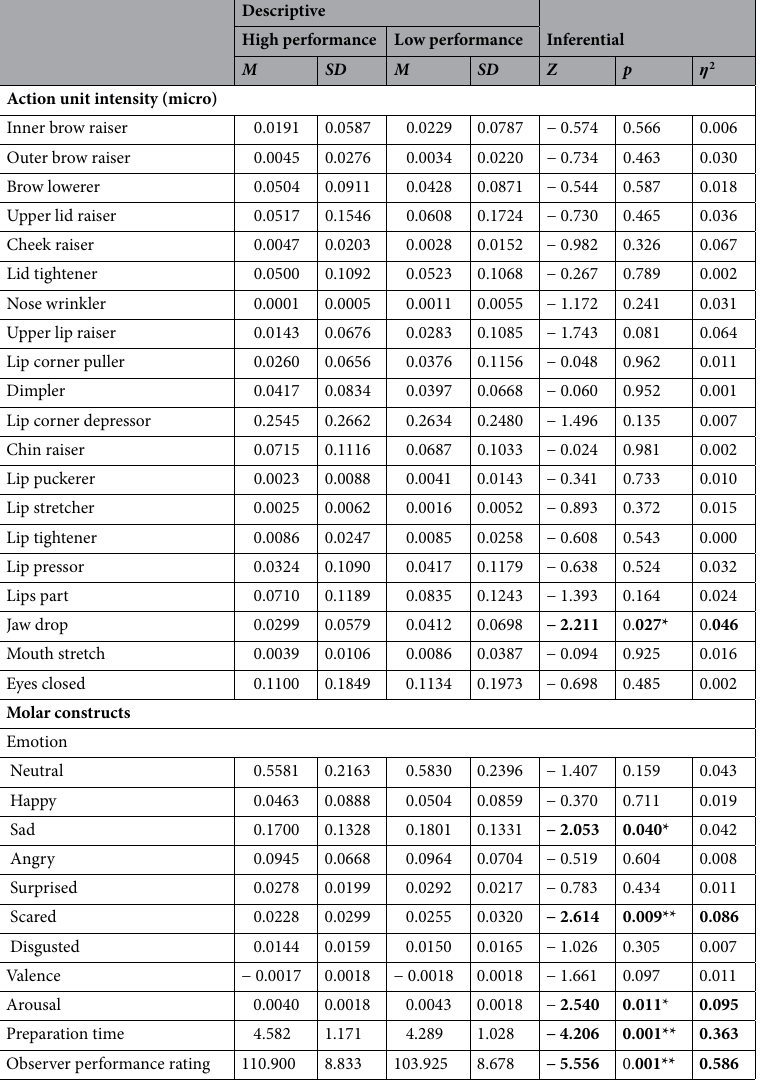
Table 1. Descriptive statistics and inferential statistics (Wilcoxon tests) as a function of high and low performance for all dart throws per shown dart player. Statistics were calculated on the mean values of the high and low performance of each players dart throws. Significant differences are printed in bold and marked with * for p < .05 and ** for p <